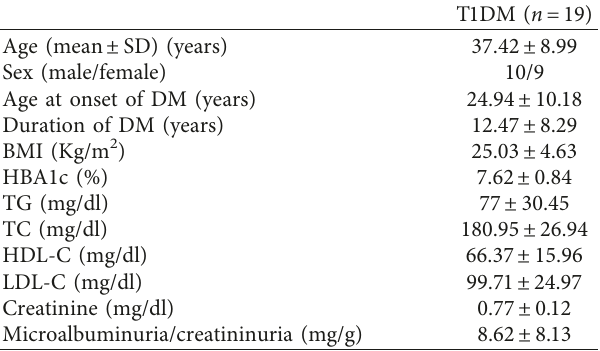
Table 1: Demographic, metabolic, and anthropometric charac- teristics of the study